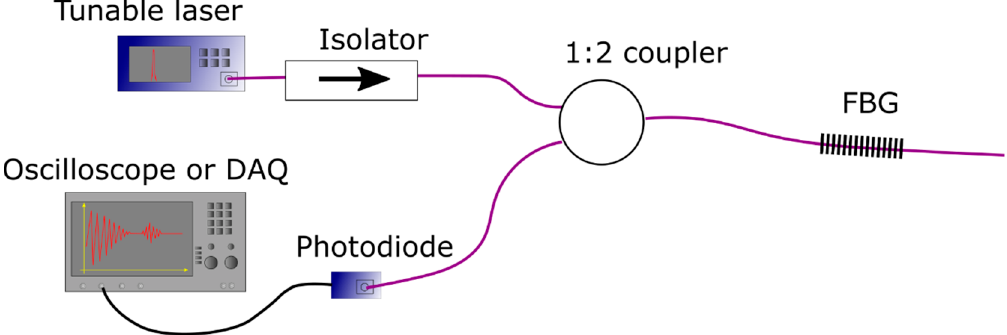
Figure 1. Acoustic emission detection setup based on the edge filter detection method. FBG: Fiber Bragg Grating.